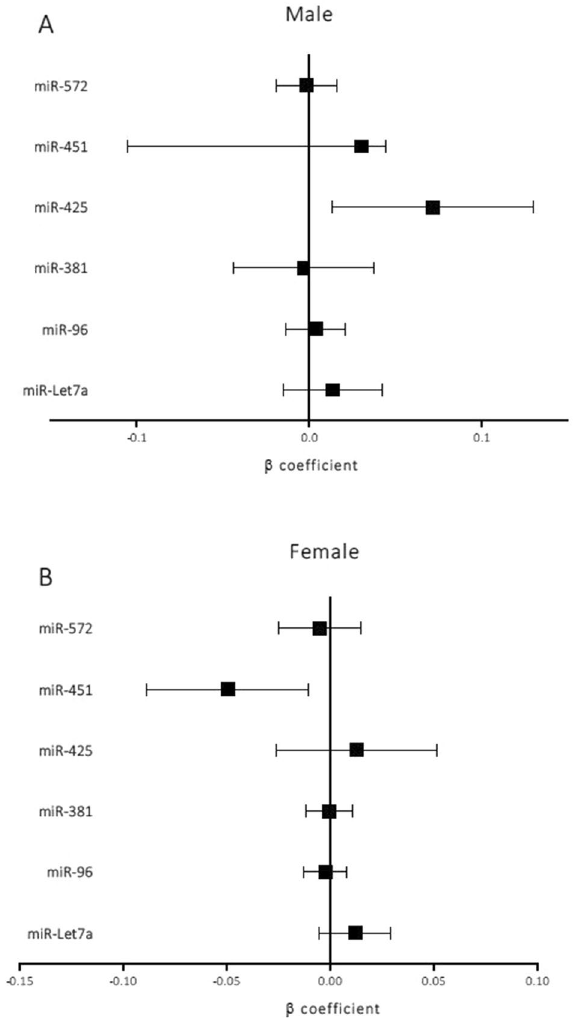
Figure 1. Adjusted β linear regression estimates with 95% confidence intervals of the effect on cIMT of a ΔCt increase (decreased expression) of the different miRs applied to men and women separately. The models are adjusted for RA disease onset, body mass index, age, ischaemic heart disease, ictus, peripheral artery disease, creatinine, hypertension, dyslipidaemia, type 2 diabetes mellitus, disease-modifying antirheumatic drugs, biological agents, corticosteroids, and non-steroidal anti-inflammatory drugs.